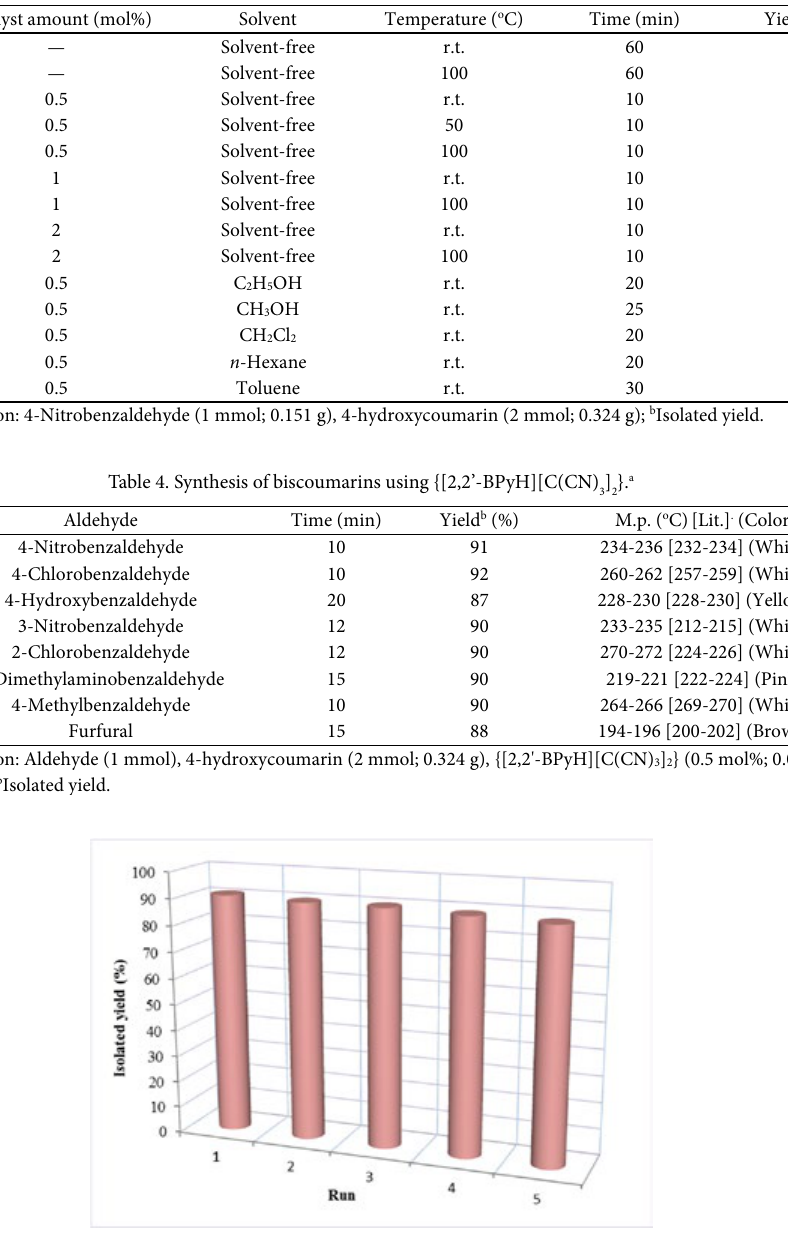
] } in the synthesis of biscoumarin for the model reaction in 10 3 2